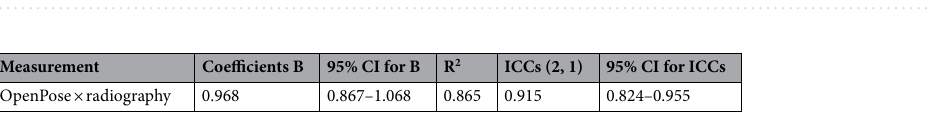
Table 1. Test–retest reliability for OpenPose and radiography. Values are presented as mean ± standard deviation. ICCs intraclass correlation coefficients, CI confidence interval.